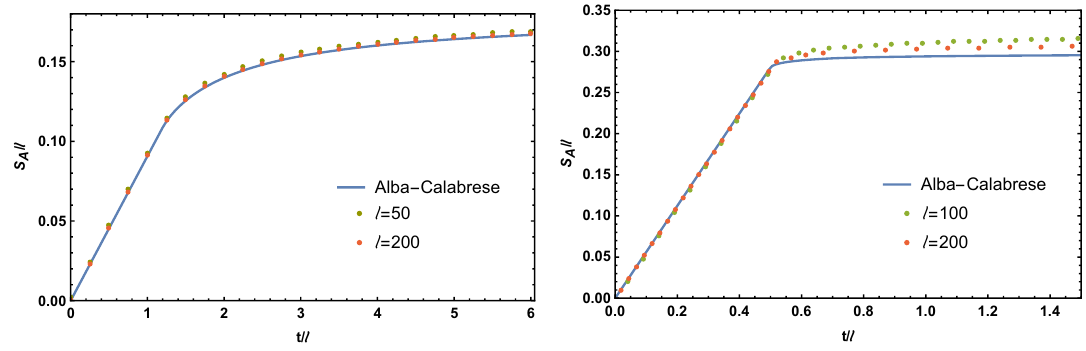
Figure 3 . Analytic versus numerical results for the evolution of EE in harmonic lattice. In the left panel we have set m 0 = 1 and m = 2 and in the right panel we have set m 0 = 1 and m = 0. In the right panel the e(cid:11)ect of the zero mode which is not captured by the analytical picture causes small deviation for t > ‘=